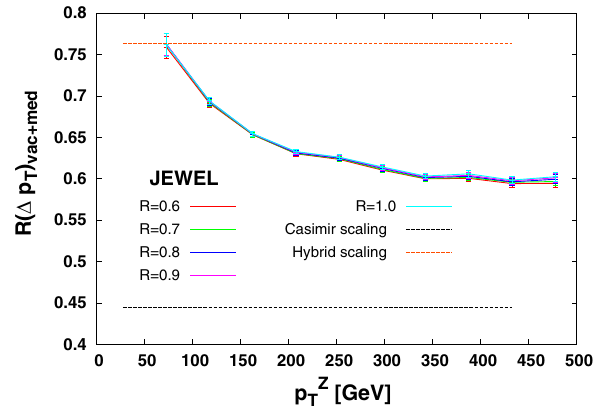
Fig. 9 Scaling for large jet parameter values of the scaling just for R (Δ p T ) v ac +